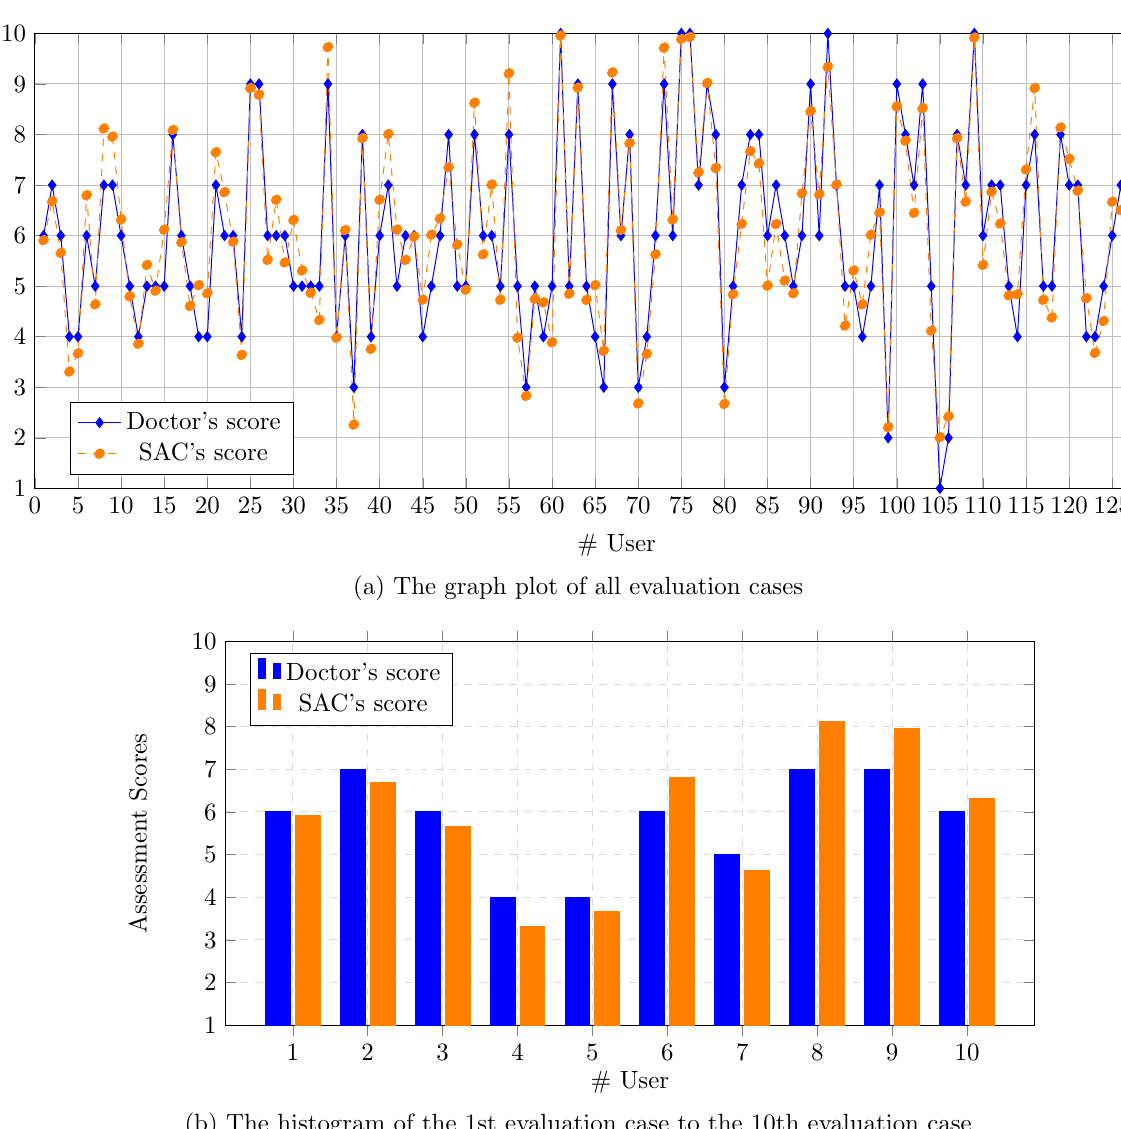
Figure 8. Graphical plot and Histogram showing accuracy comparison between SAC’s assessment scoring of FBC patients versus the doctors’ benchmark FBC screening